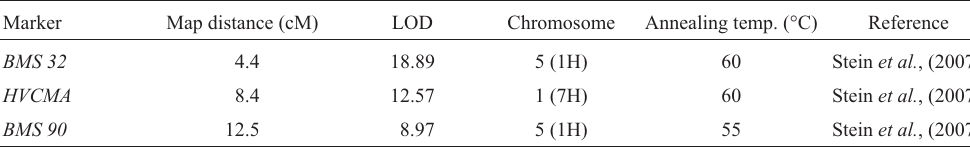
Table 5 - SSRs markers, alleles, chromosome locations and map